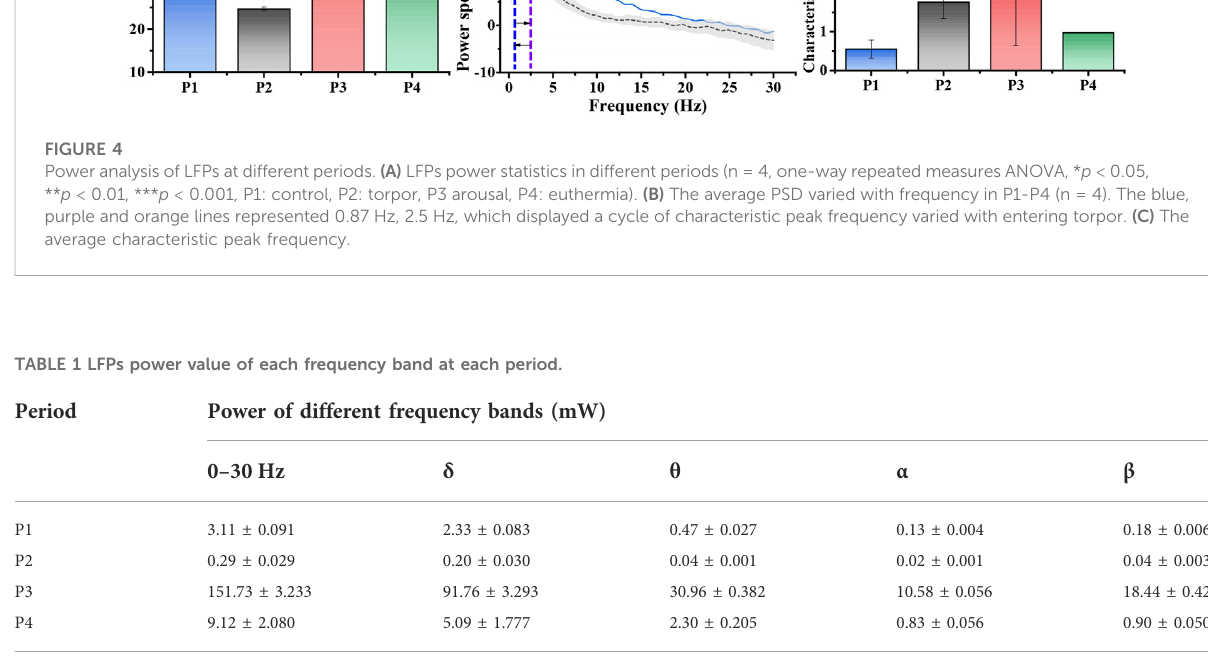
torpor. Figure 5A revealed the statistical results of the spike waveform in entering and away from the torpor whole period, including average waveform value of example 4 channels (Supplementary Figure S7). To quantify our results, we further processed the waveform on the basis of Figure 5A and Supplementary Figure S8. According to the statistical results of spike amplitude in each period, the amplitude of entering torpor decreased to 43.97% (Figure 5B, n = 4, p -value conforming to one-way repeated measures ANOVA, Tukey ’ s posthoc test;